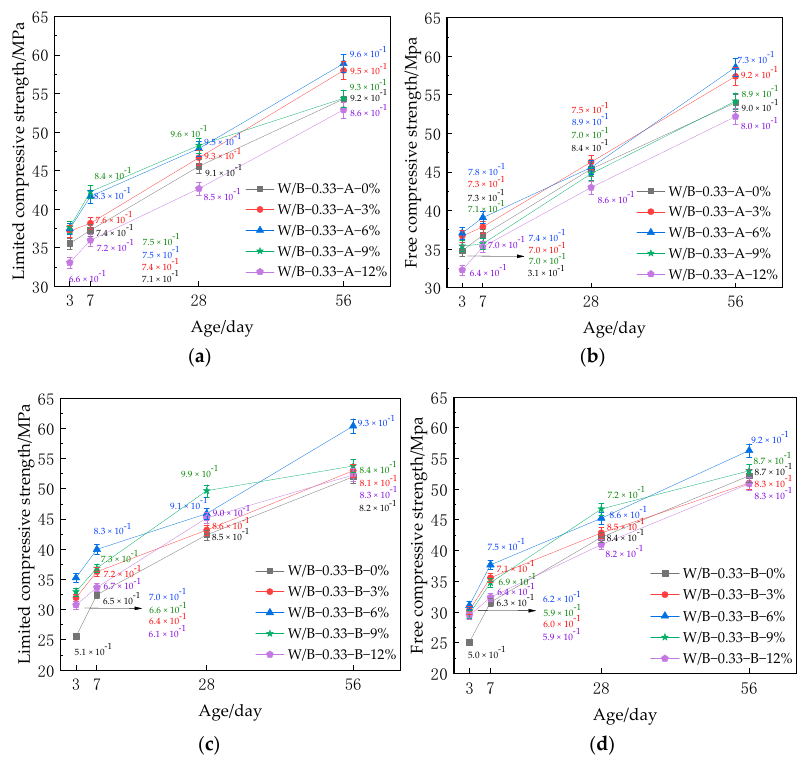
Figure 4. Compressive strength of concrete with water-binder ratio of 0.33. ( a ) Limited strength of group A, ( b ) free strength of group A, ( c ) limited strength of group B, ( d ) free strength of group B.